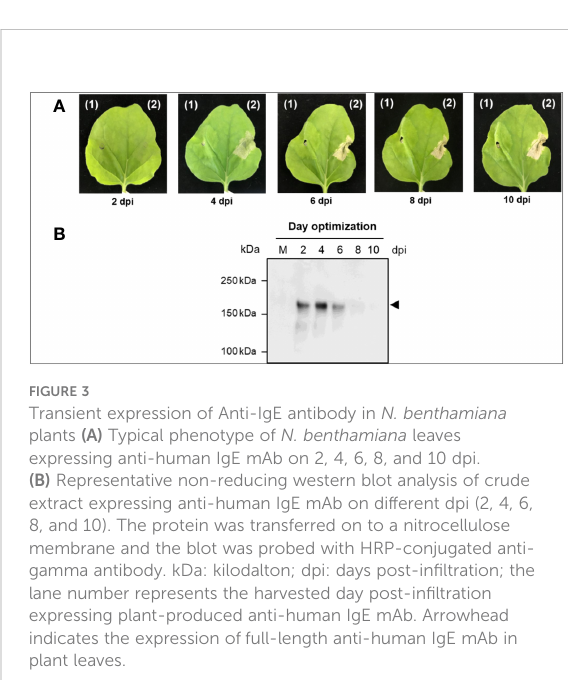
FIGURE 3 Transient expression of Anti-IgE antibody in N. benthamiana plants (A) Typical phenotype of N. benthamiana leaves expressing anti-human IgE mAb on 2, 4, 6, 8, and 10 dpi. (B) Representative non-reducing western blot analysis of crude extract expressing anti-human IgE mAb on different dpi (2, 4, 6, 8, and 10). The protein was transferred on to a nitrocellulose membrane and the blot was probed with HRP-conjugated anti- gamma antibody. kDa: kilodalton; dpi: days post-in fi ltration; the lane number represents the harvested day post-in fi ltration expressing plant-produced anti-human IgE mAb. Arrowhead indicates the expression of full-length anti-human IgE mAb in plant